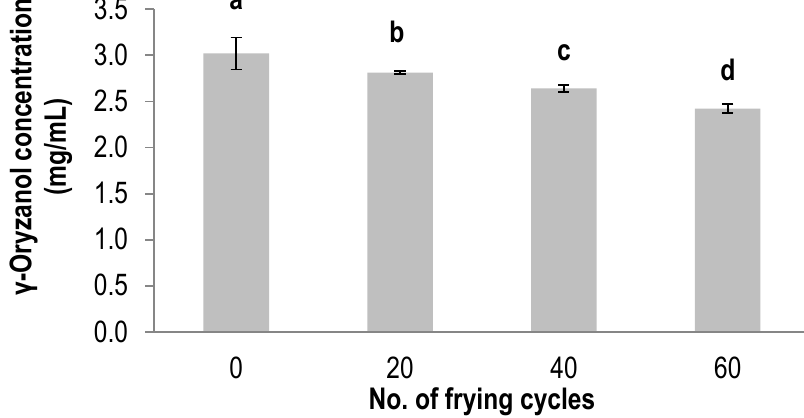
Figure 4. The degradation of γ-oryzanol in RBO during deep-frying. The values given are means ± standard deviation of a triplicate analysis. The values marked with the same letters are not significantly different at p < 0.05 analyzed using the Duncan multiple range